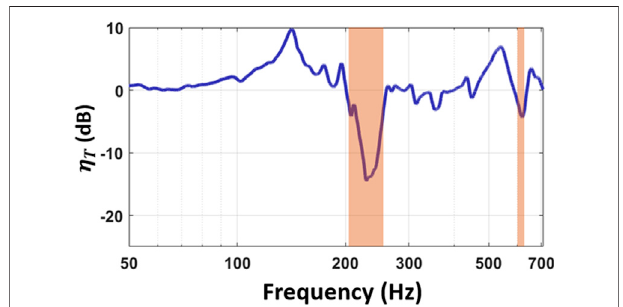
FIGURE 9 | Measured transmissibility of the layered metamaterial vibration attenuation structure showing two notable frequency bandgaps, i.e., 205 – 257 Hz and 587 – 639 Hz.